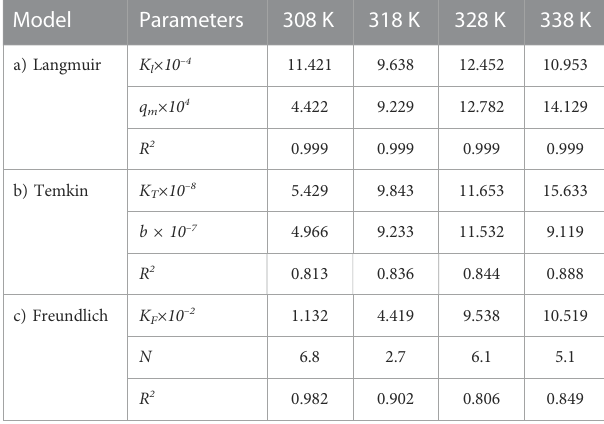
The italic values are parameters of the